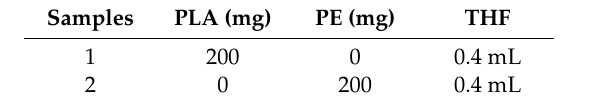
Table 1. Films fabricated from polyester (PE), poly(lactic acid (PLA) or PLA-PE mixtures. Samples PLA